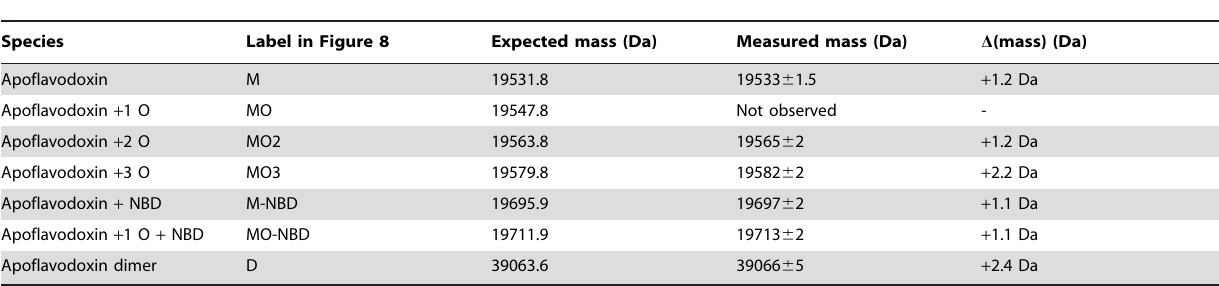
Table 2. LC-MS analysis of (apo)flavodoxin.